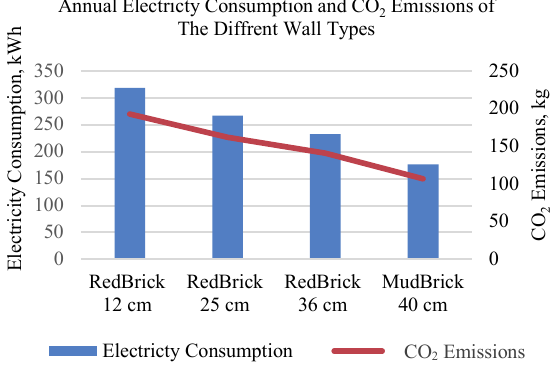
Fig. 3. Annual Electricity Consumption and CO 2 Emissions for Wall Section Pre and Post